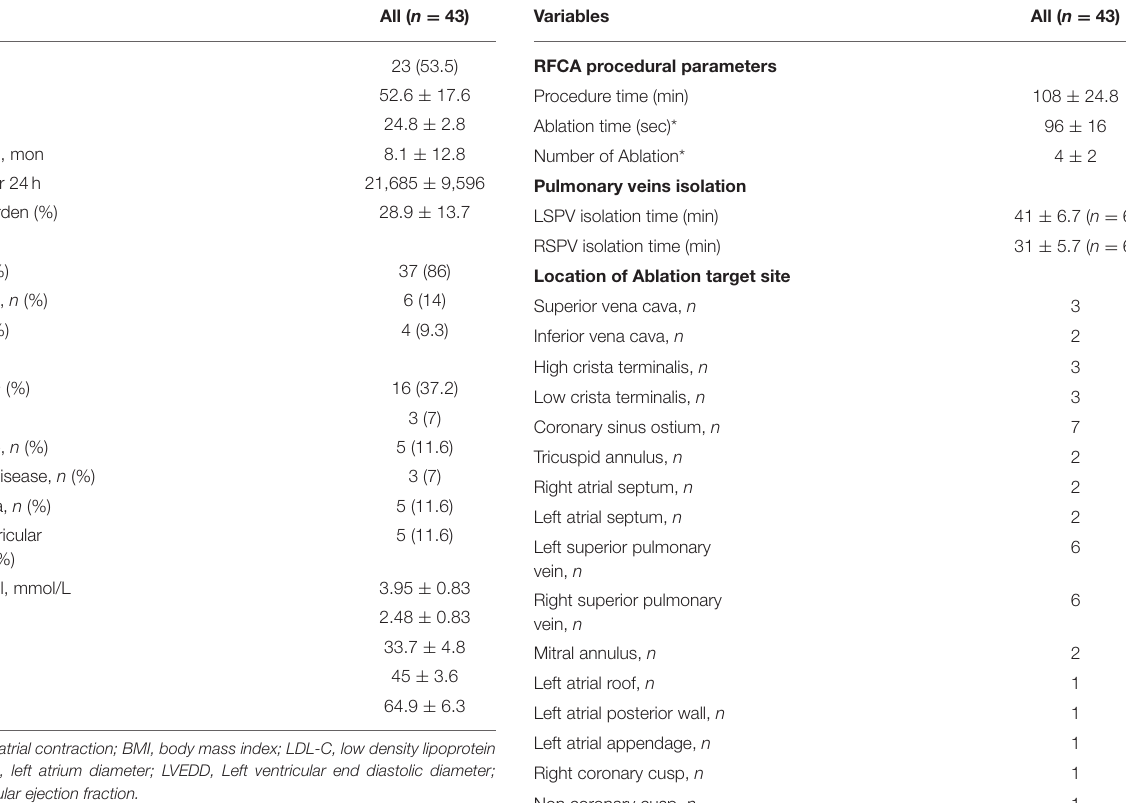
TABLE 1 | Patient characteristics. TABLE 2 | Parameters of mapping and